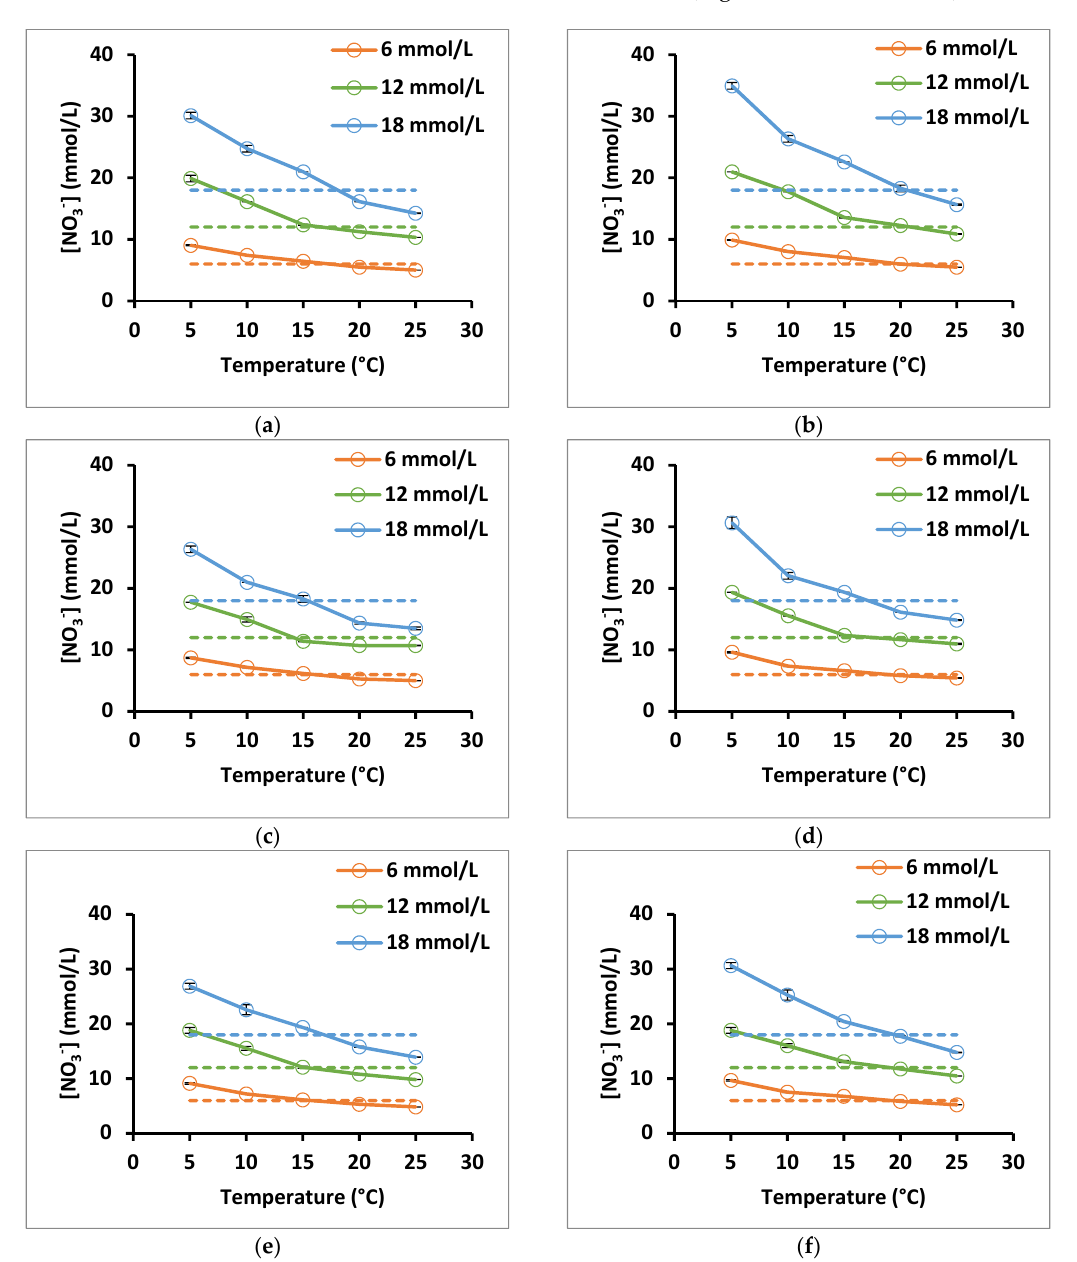
each of the six different combinations of ISE meter and NO 3 − source, the range of slopes was − 3.23 to − 4.22, the range of intercepts was 54.1 to 85.1, and the range of coefficient of at higher sample temperatures (Figure 1a–f). The average coefficient of variation for all relative error was zero were 17.0 to 20.2 ◦ C (Figure 2a–f and Table 1). measurements using both ISE meters was 1.8%.